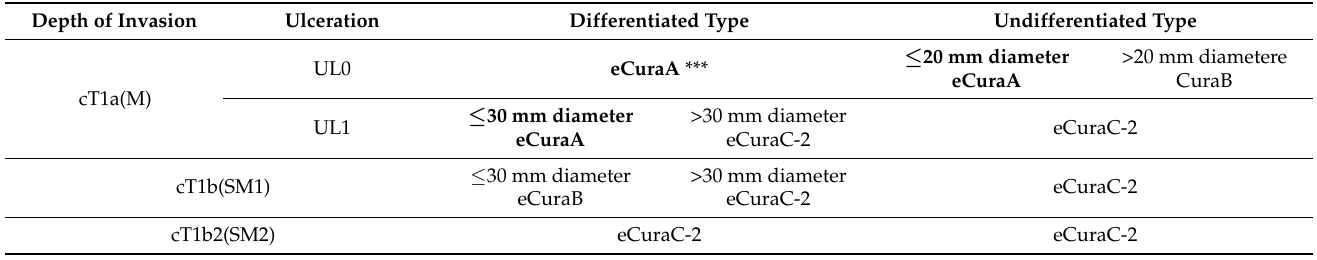
Table 2. Curability of endoscopic resection of gastric cancer * ,